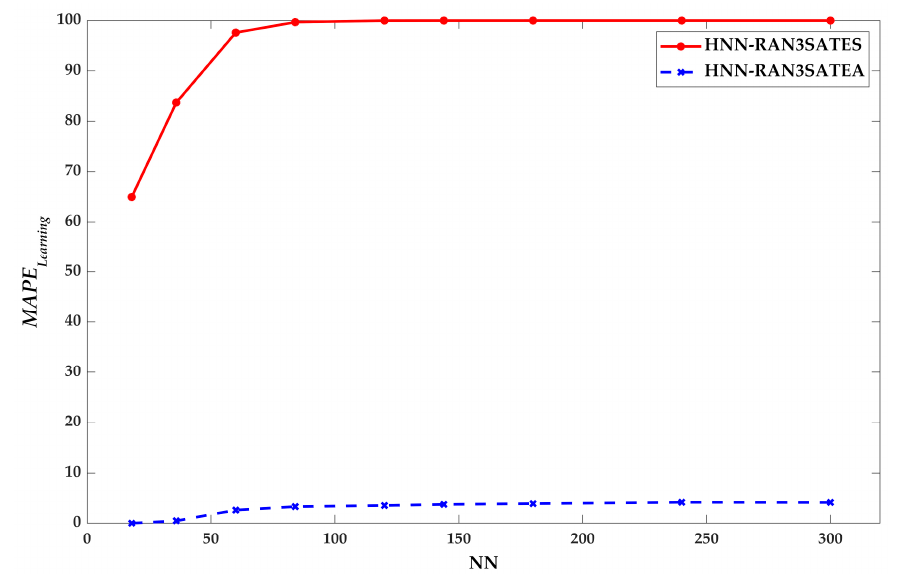
Figure 5. MAPE Learning for HNN-RAN3SAT Figure 5. Learning MAPE for HNN-RAN3SAT model.